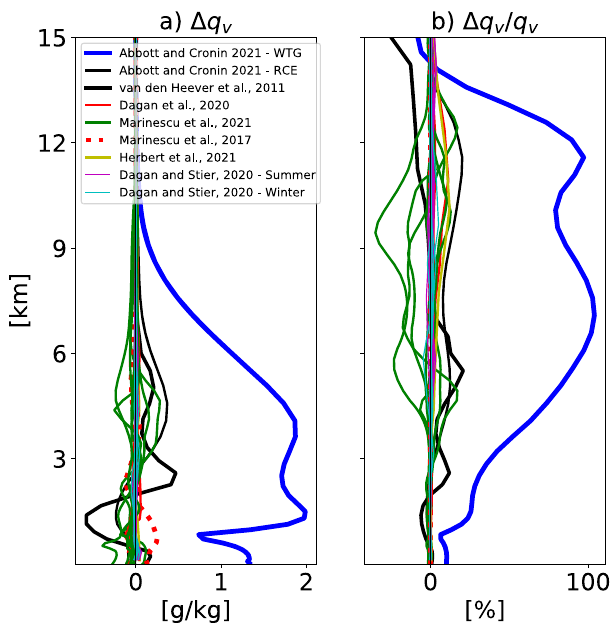
Fig. 1 Water vapor mixing ratio response to aerosol perturbation in deep- convective clouds simulations. Vertical pro fi les of the domain and time mean a change in water vapor mixing ratio — q v , and b relative change in q v due to an aerosol perturbation (normalized to an order-of-magnitude increase in aerosol concentration) from 34 different sets of simulations of deep-convective cloud fi elds representing a wide range of environmental conditions and produced by numerous different models. The blue curve presents results from idealized WTG simulations, black curves present results from idealized RCE simulations, whereas the rest of the curves are based on realistic simulations (the different green curves represent different models participated in Marinescu et al. 11 , see Fig. 2 for a more detailed view of the realistic simulations). For details about the different simulations, please see the Methods